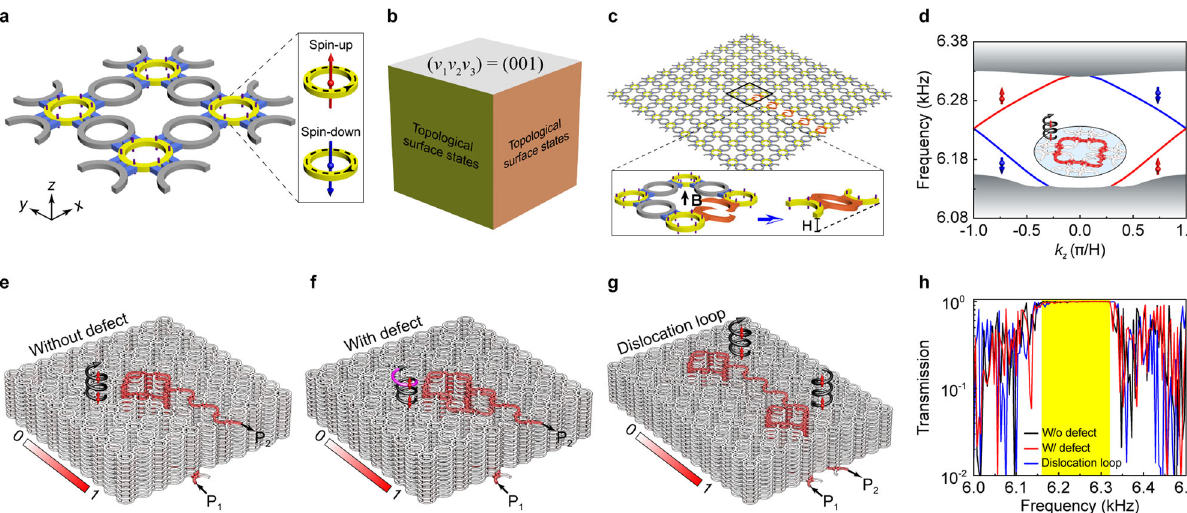
Fig. 2 Numerical demonstrations of the acoustic TDMs and their topological transports. a Monolayer structure used for stacking our 3D ATI. It consists of a square lattice of site ring-waveguides (yellow) connecting with straight tubes (blue) and coupler ring-waveguides (gray) in the x – y plane, together with vertical narrow tubes (purple) for interlayer couplings in the z direction. The in-plane and out-of-plane lattice constants are a ¼ 208 mm and H ¼ 27 : 5 mm, respectively. The inset de fi nes the pseudospins according to the circulating directions of sound in the site ring-waveguides. b Bulk topology of the 3D ATI, manifested as topological surface states only on the side surfaces. c Supercell used to simulate the acoustic TDMs. The screw dislocation is created by replacing a chain of the in-plane couplers with titled interlayer couplers (orange). The inset ampli fi es the dislocation and presents an equivalent but more intuitive demonstration for the tilted interlayer coupler by considering the periodicity of the system along z axis. d Dislocation-projected band structure. The color lines represent helical TDMs and the gray shadows represent bulk states. Inset: Pressure amplitude distribution exempli fi ed for a pseudospin-up TDM at 6.27 kHz, where the bold spiral arrow visualizes its propagation. e Field pattern simulated at 6.27 kHz for a fi nite sample that contains a screw dislocation in its interior and two edge dislocations on the top and bottom layers. f The same as e but for the system with a defect on the top layer. g Similar simulation for a sample with a dislocation loop. h Transmission spectra for the three dislocation systems in ( e – g ), which characterize quantitatively the topological robustness of the TDMs within the nontrivial band gap (yellow